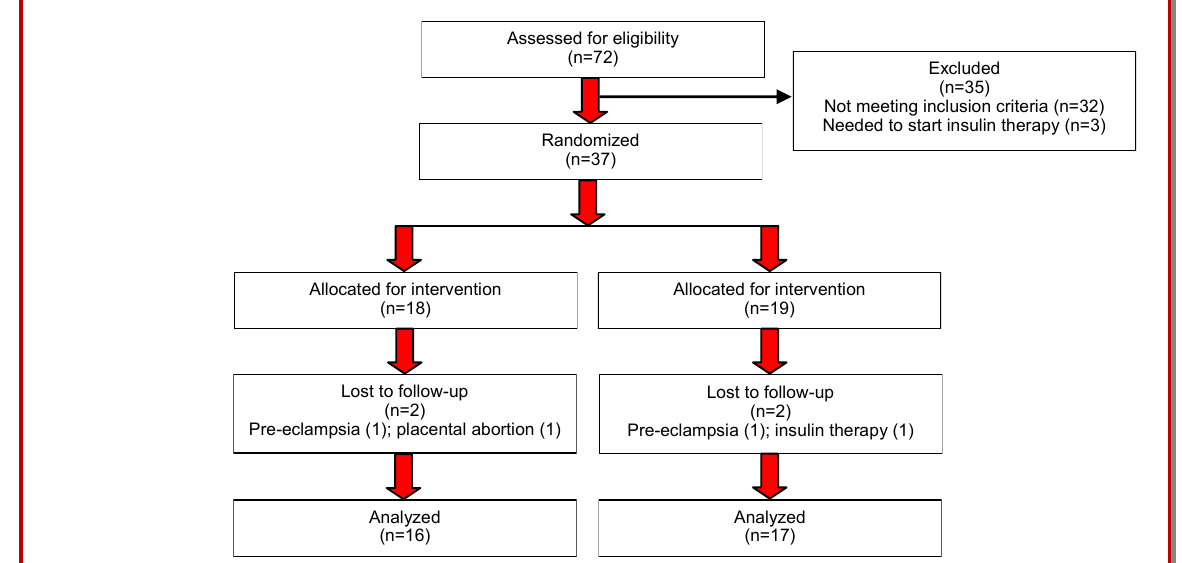
Figure 1: Summary of patient flow